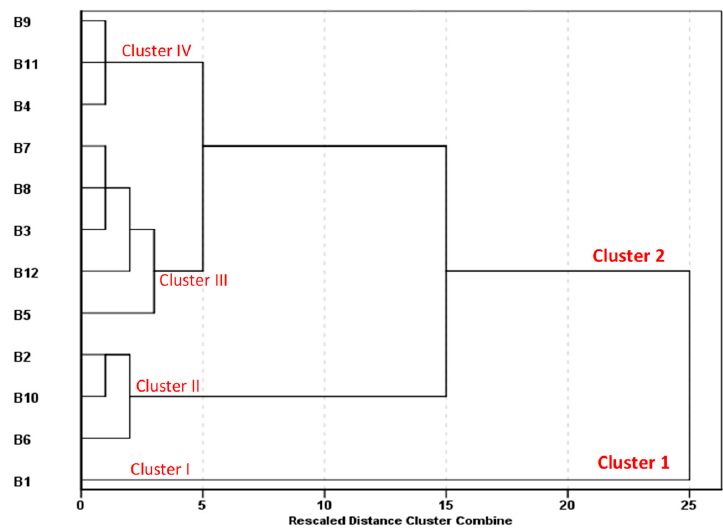
Figure 5. Hierarchical cluster analysis dendrogram showing clusters of 12 bottled water brands with respect to their chemical composition.